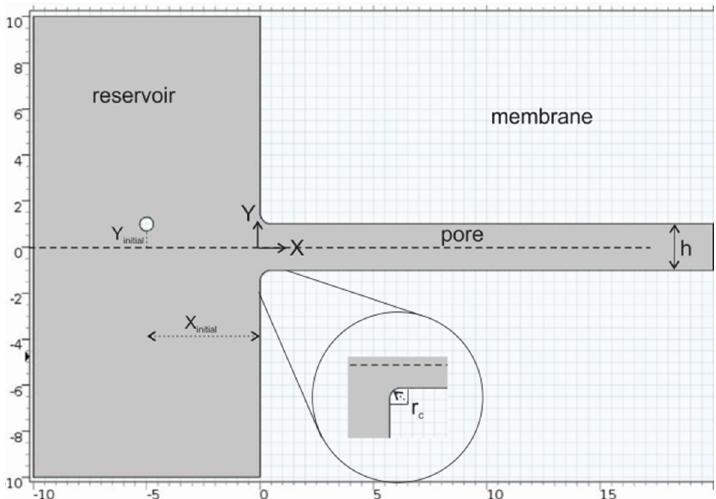
Figure 1. 2D modeling domain: single ‐ channel pore which is infinite in extent in the Z direction. The position variables X and Y are dimensionless, defined with respect to the pore ½ width, h/2 . This image only shows a portion of the reservoir; the actual domain spanned from Y = − 24 to Y = +24.